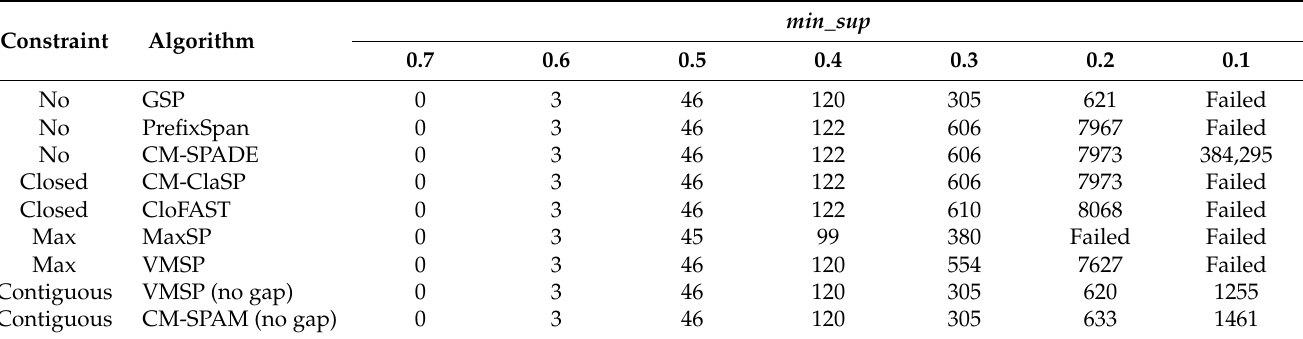
Table 5. Number of output patterns of Algorithms with different minimum support ( min _ sup ) categorized by their